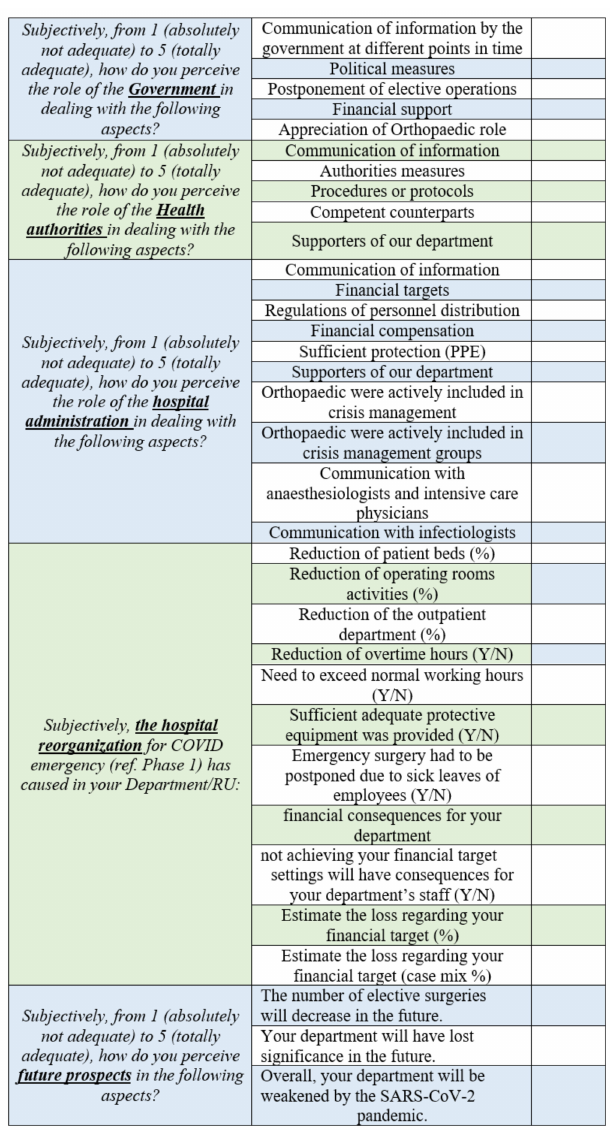
Figure 1. The questionnaire used in the